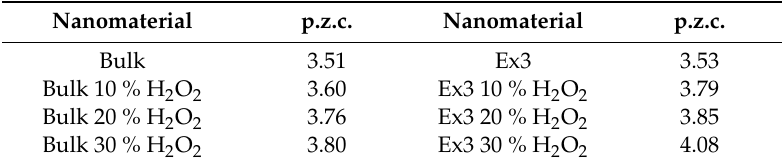
Table 4. Points of zero charges of bulk and selected exfoliated GCN nanomaterials.